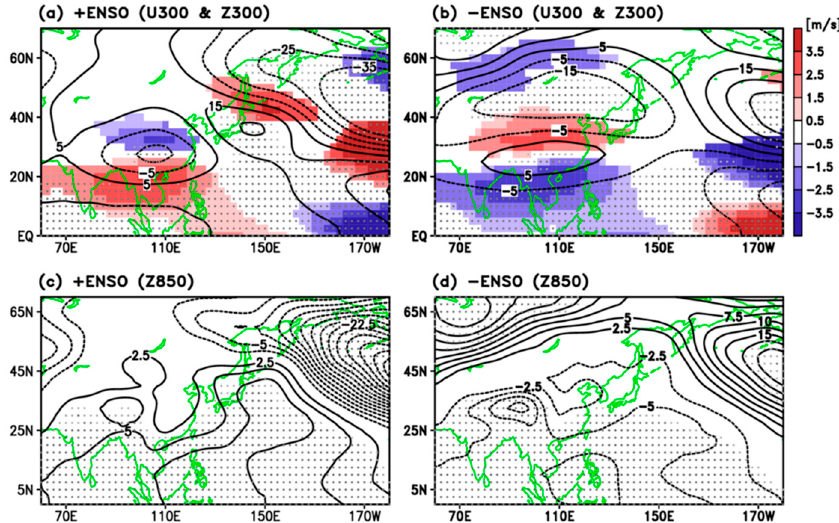
Figure 6. Composite maps of zonal wind (shading) and geopotential height (contours with interval 10m) anomalies at 300hPa in winter season for ( a ) +ENSO and ( b ) –ENSO. ( c ) and ( d ) are same as ( a ) and ( b ) but for geopotential height anomalies at 850hPa. Light (dark) gray dots denote grid points which satisfy 90% (95%) confidence level through the two-tailed Student’s T-test. Zonal wind in ( a ) and ( b ) is shaded only for the grids which satisfy 90% confidence level.